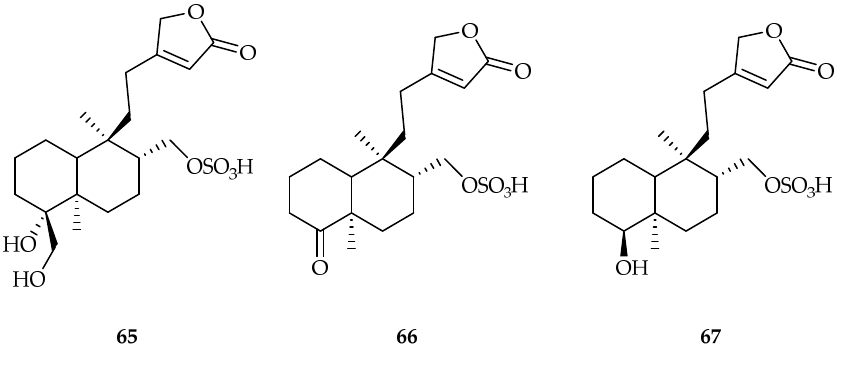
Figure 27. Structures of graveospene A 63 [42] and cracroson F 64 [43]. Sheareria A–C 65 – 67 , three novel neo -clerodane diterpenoids, were isolated from the whole herb of Sheareria nana (Asteraceae) distributed in northeast, southwest, and central- south of China (Figure 28). Compound 65 was the first natural sulfated neo -clerodane diterpenoid, while compounds 66 and 67 were the first natural sulfated 18-nor- neo -clerodane diterpenoids. All isolated compounds were evaluated for their cytotoxicity against the human HeLa, PANC-1 (human pancreatic), and A549 cell lines. Compounds 65 and 66 exhibited broad-spectrum and moderate to potent cytotoxicity, with IC 50 values below 10.0 μM; compound 67 exhibited more selective activity against the PANC-1 cell line (IC 50 9.8 μM) than against the A549 and HeLa cell lines (IC 50 values of 12.5 and 17.2 μM, respectively), using etoposide as a positive control [44].